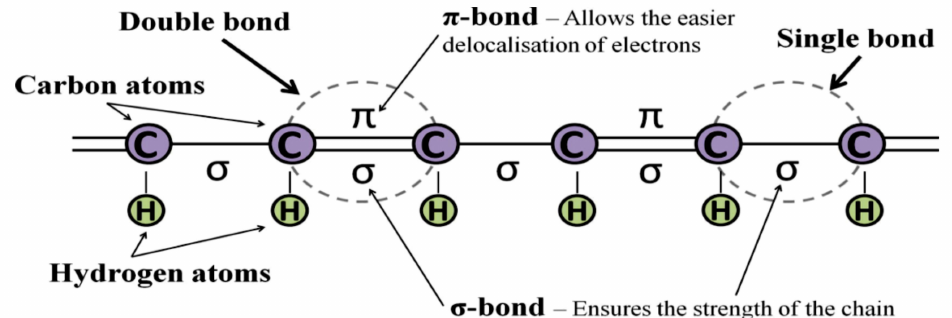
Figure 3. A simplified schematic of a conjugated backbone of conductive